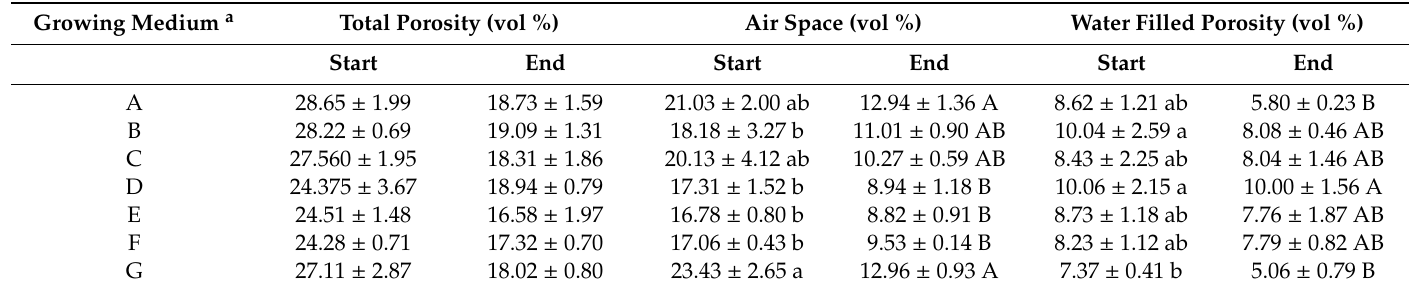
Table 3. Physical properties of growing media in the trial period. Values are means ( ± standard deviation). Values in a column indicated by di ff erent letters are significantly di ff erent (lowercase p < 0.05, uppercase p < 0.001) based on Tukey’s HSD